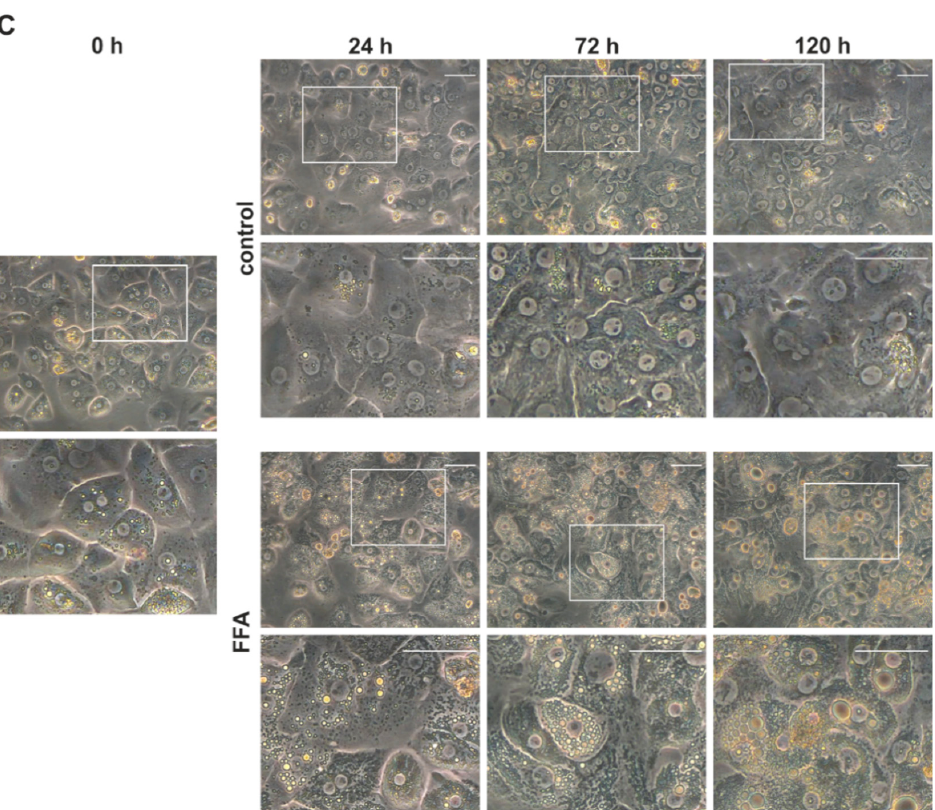
Figure 1. Increased lipid level after induction of in vitro steatosis. Primary human hepatocytes (PHHs) were continuously treated with control medium or 0.6 mM free fatty acids (FFA) every 24 h over five days. ( A , B ) Lipid level was quantified with Oil Red O assay. ( A ) Initial lipid content of the PHHs relative to sulforhodamine B (SRB). Depending on the initial lipid content, hepatocytes from donors 1–3 were classified in the low-lipid-containing hepatocyte (LLCH) group and those from donors 4–6 in the high-lipid-containing hepatocyte (HLCH) group. Data are shown as the means ± SD, n = 3, unpaired t-test, p < 0.05. ( B ) Quantification of the lipid content in the LLCH and HLCH cultures. Data are shown as the means ± SD, n = 3, two-way ANOVA, and post hoc Dunnett or Bonferroni analysis. A p value of 0.05 or less (*) was considered significant. For the details on the statistical evaluation, see Supplementary Table S1A. ( C ) Microscopic evaluation of the lipid accumulation in representative PHH cultures of donor 1 (magnification 32×). The white box indicates the enlarged section below. The scale bar is 50 µm.